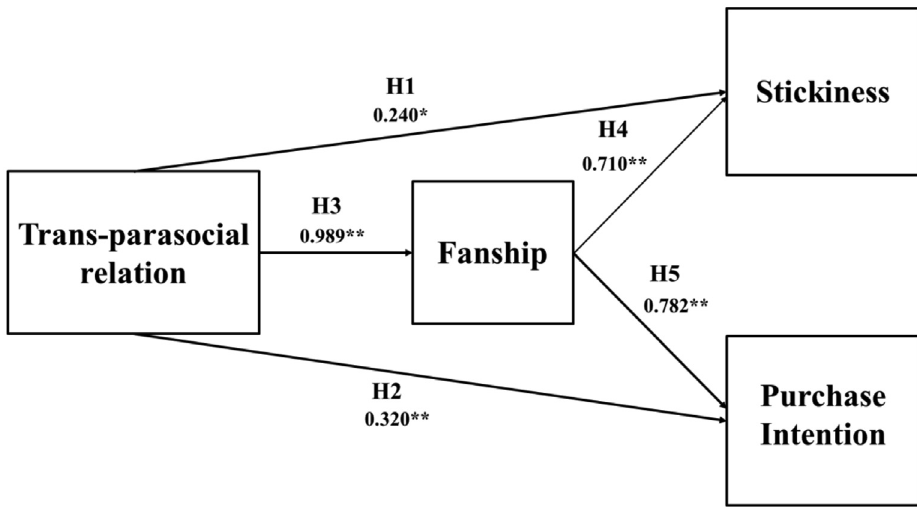
Fig. 1. Results for Structural Equation Modeling (SEM). (Note: The path coef fi cients are standardized path coef fi cients, ** p < 0.01, * p <